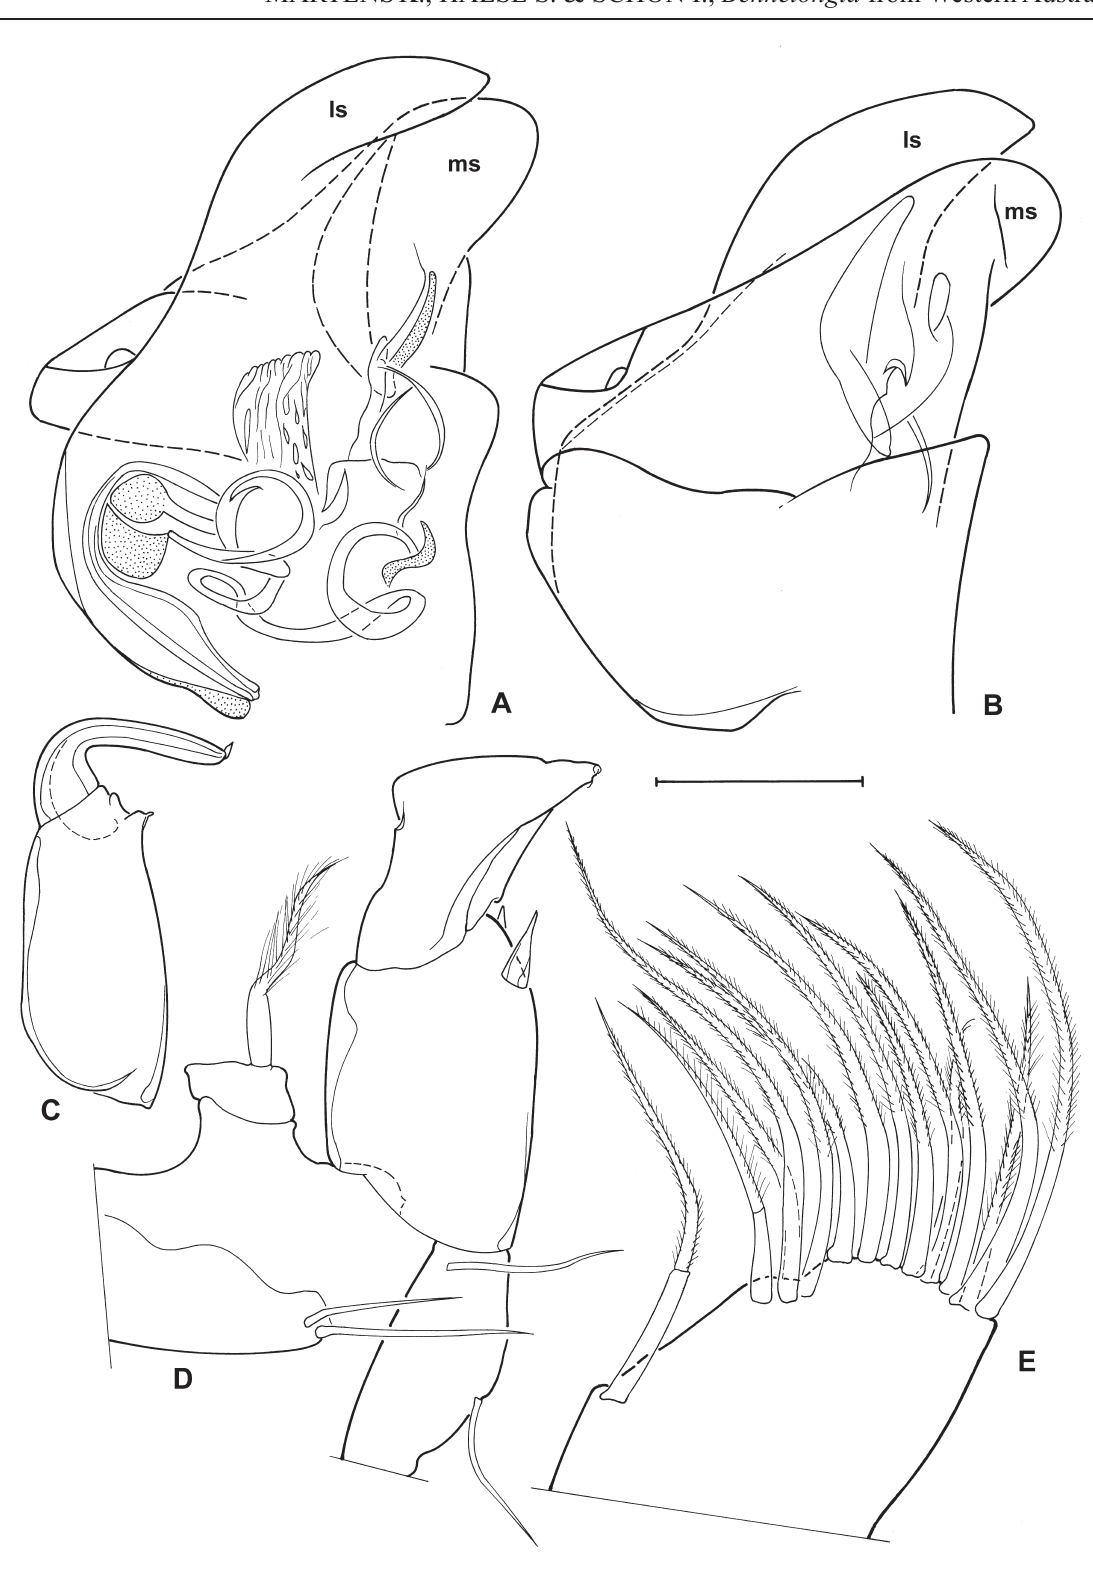
Fig. 8. Bennelongia cygnus sp. nov. (all from holotype ♂, WAM.C49370). A . Hemipenis, showing internal anatomy of labyrinth. B . Outline of other hemipenis. C . Left prehensile palp. D . right T1, showing partial chaetotaxy and right prehensile palp. E . right T1, showing distal chaetotaxy of endopodite. Scales: A-D = 92 µm; E = 37